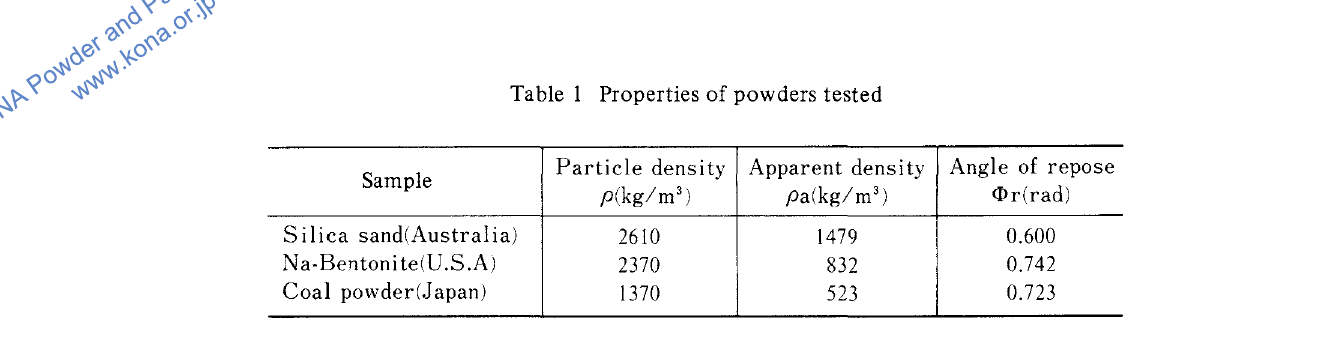
Table 1 Properties of powders